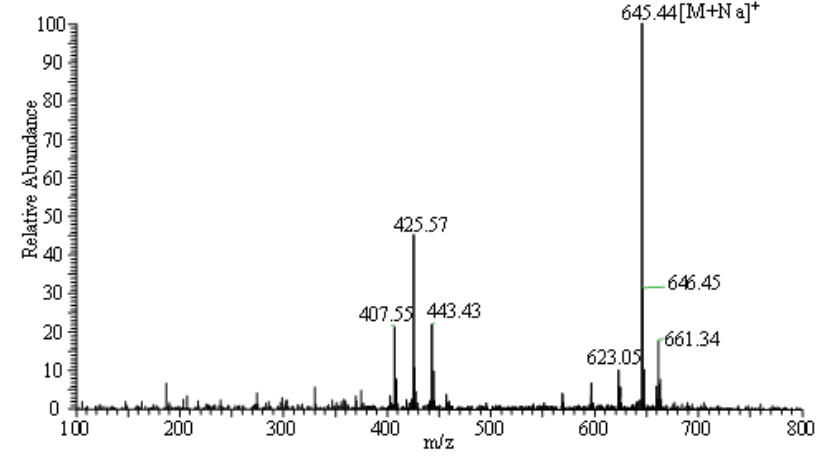
Figure 3. ESI/MS spectra of G-M1. Total ion chromatograms from 100 to 800 m/z in ESI positive mode.